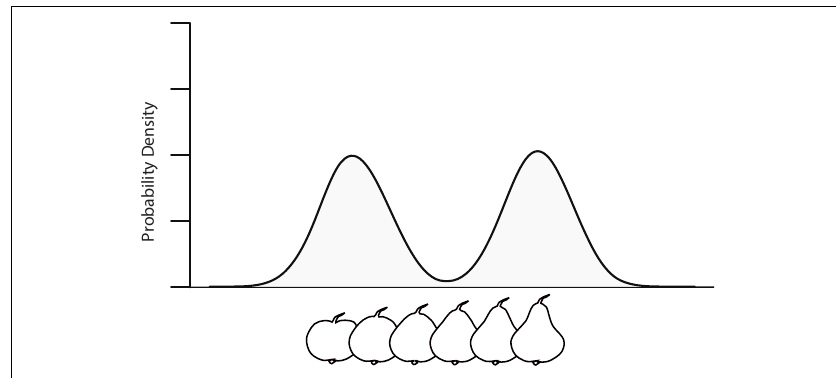
FIGURE 1 | Probability density for a dimension for which we can distinguish the round shapes characteristic of an apple from the cone shape characteristic of a pear, conditioned on (i) the sensory input generated by the bottom view of the fruit, (ii) the prior density describing the frequency of different shaped fruits in the world, and (iii) the hypothetically performed action of, say, grasping the fruit from the bottom and turning it so as to view it from the side. them apart). The Laplace